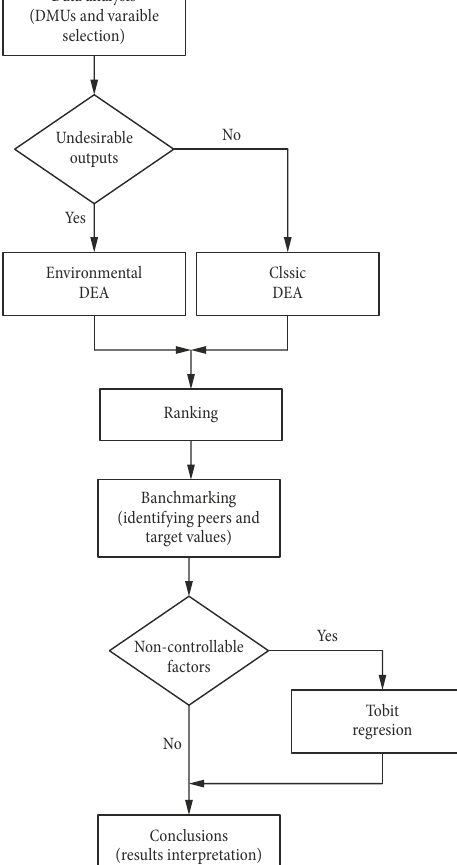
Fig. 7. Algorithm of the proposed framework of